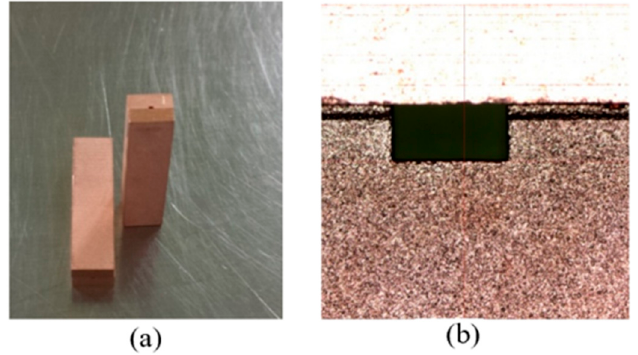
Table 5. Comparison between microfabricated and designed dimensions.